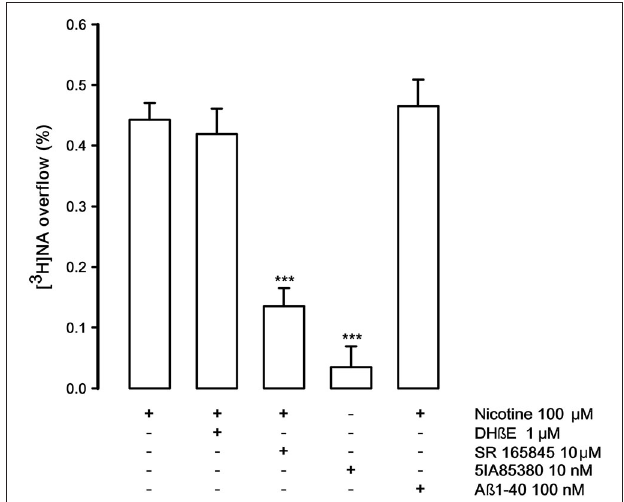
FIGURE 5 | Effect of dihydro- β -erythroidine (DH β E), SR 165845 and A β 1-40 on nicotinic-evoked [ 3 H]NA overflow from rat hippocampal synaptosomes. Data are means ± SEM of at least four experiments run in triplicate, *** P < 0.001 versus nicotine. One-way ANOVA followed by Bonferroni post-hoc test.